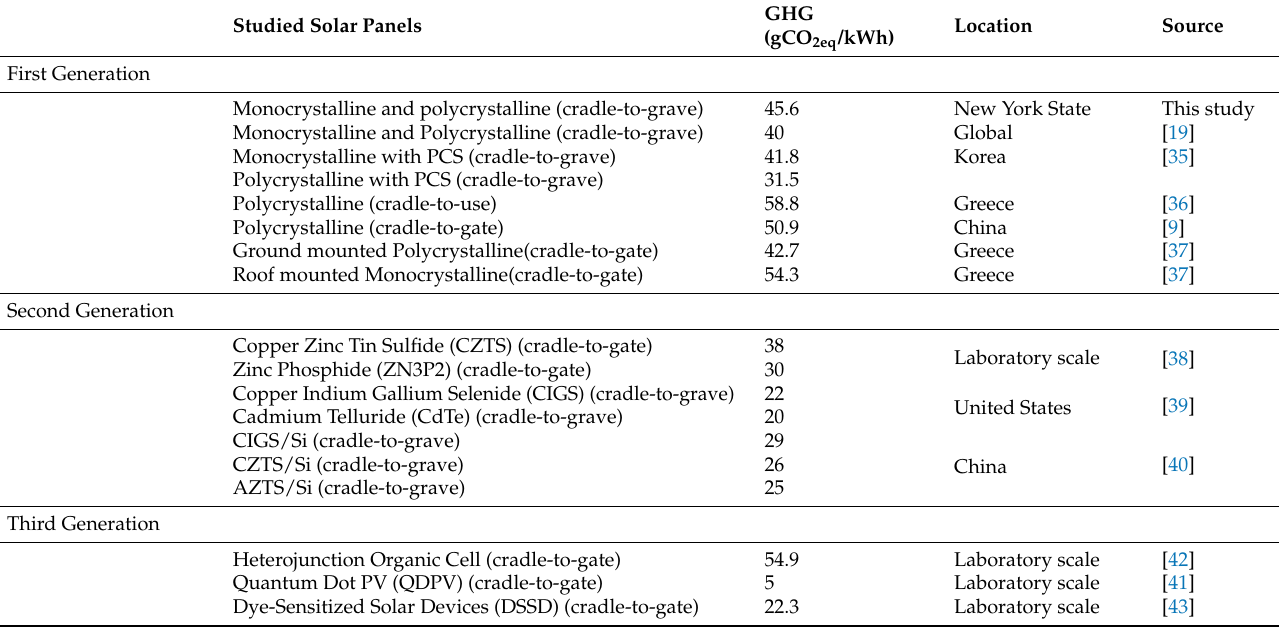
Table 5. Life cycle greenhouse (GHG) emissions comparison of first, second, and third-generation solar photovoltaic